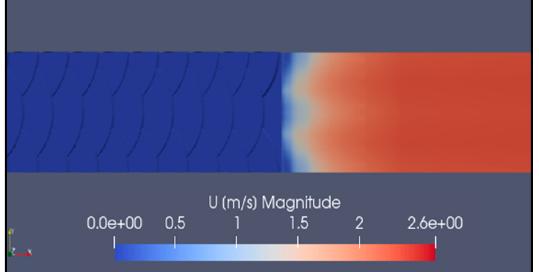
Figure 14. Streaks formation observed on the velocity field at back tested plate.